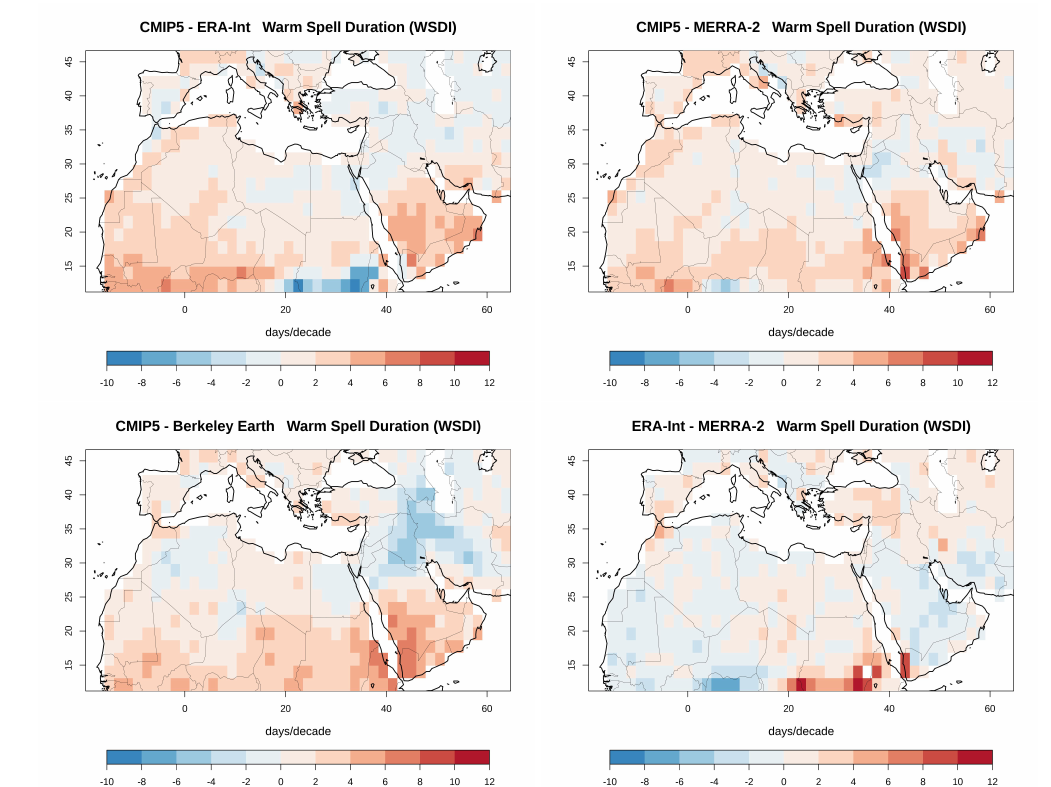
Figure A7. Same as Figure A5 but for the Warm Spell Duration